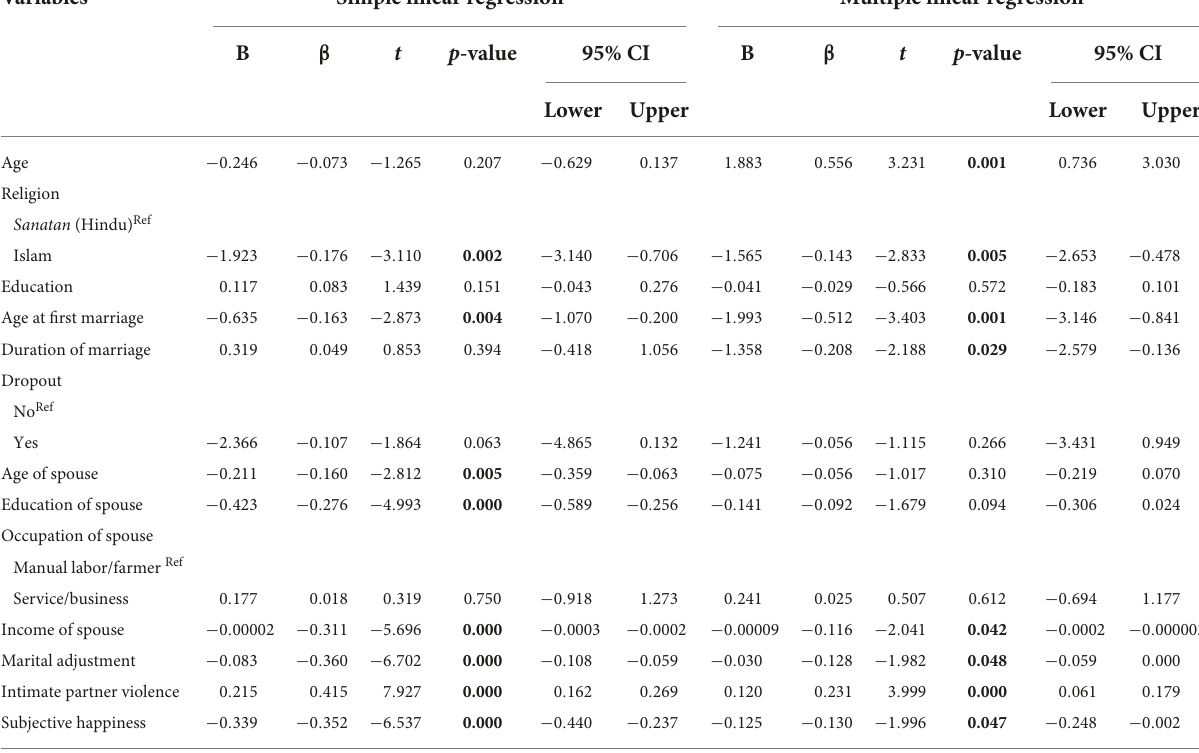
TABLE 2 Predicting depression among early married girls during the pandemic. Variables Simple linear regression Multiple linear regression